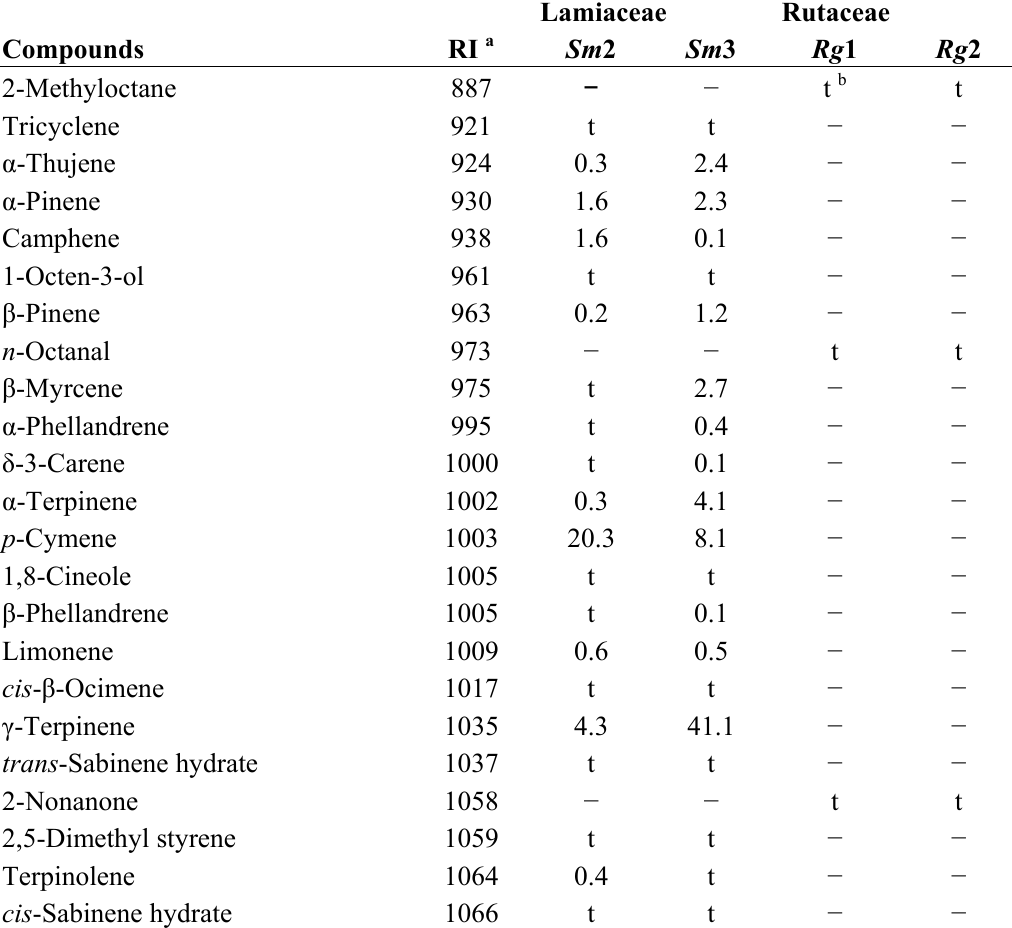
Table 4. Chemical composition of essential oils and volatiles of Portuguese plants resulting in 100% mortality of Bursaphelenchus xylophilus at 2 mg/mL.